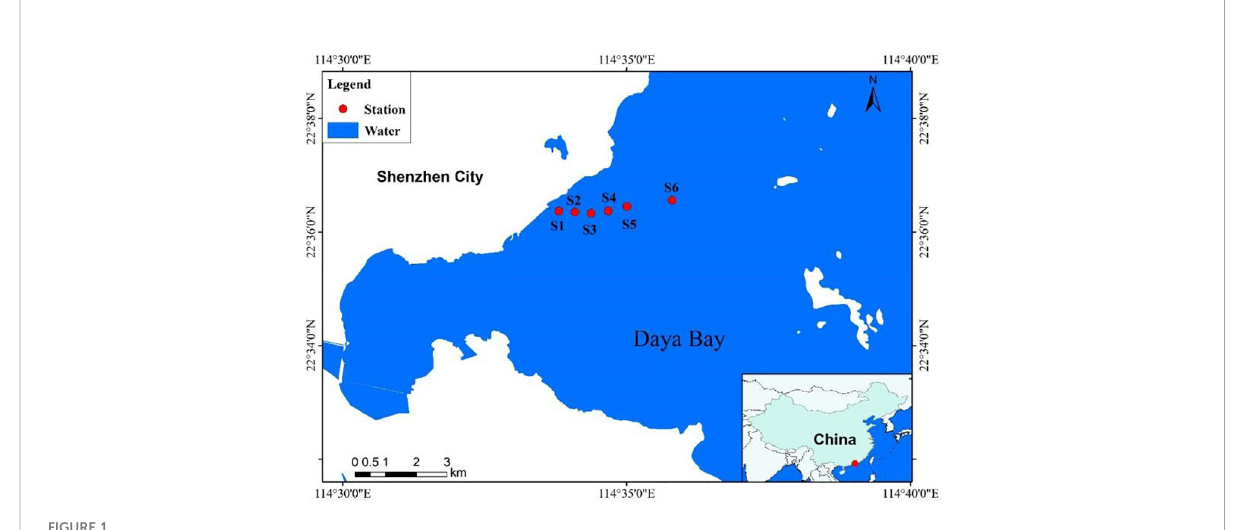
FIGURE 1 Maps of sampling stations in Daya